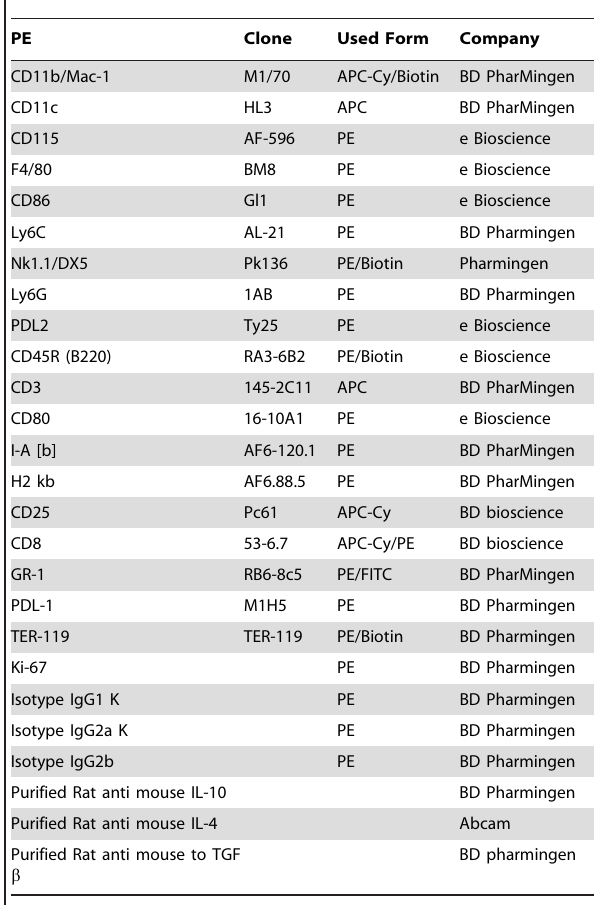
Table 1. Conjugated monoclonal